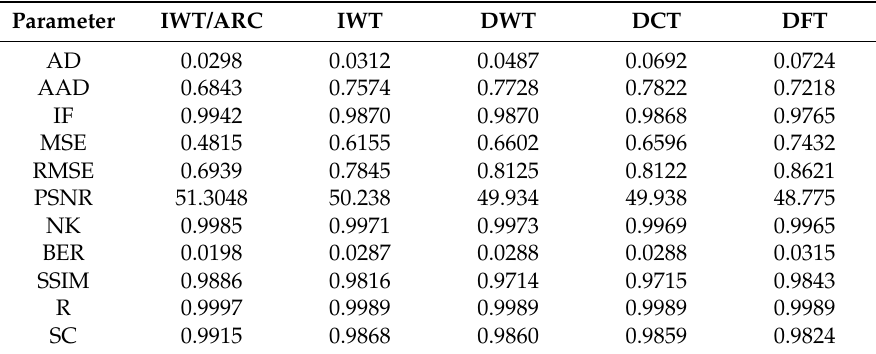
Table 2. Image analyses for cover image 1.